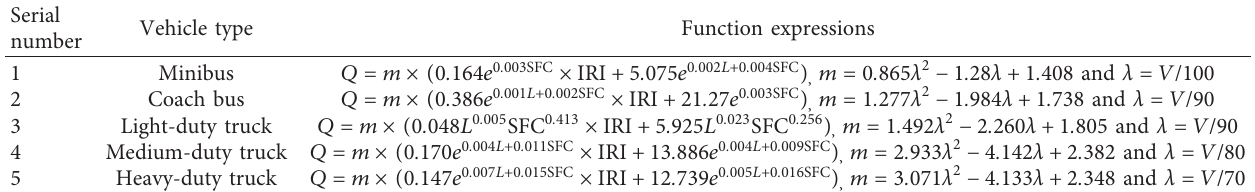
Table 8: Modified model for roughness and fuel consumption.